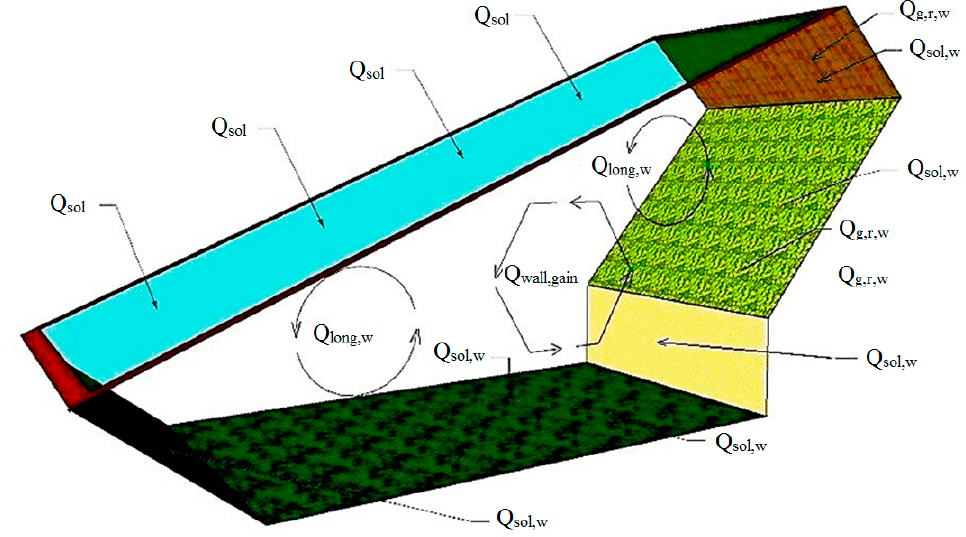
Figure 4. Radiative Heat Flows to the Walls and floor.